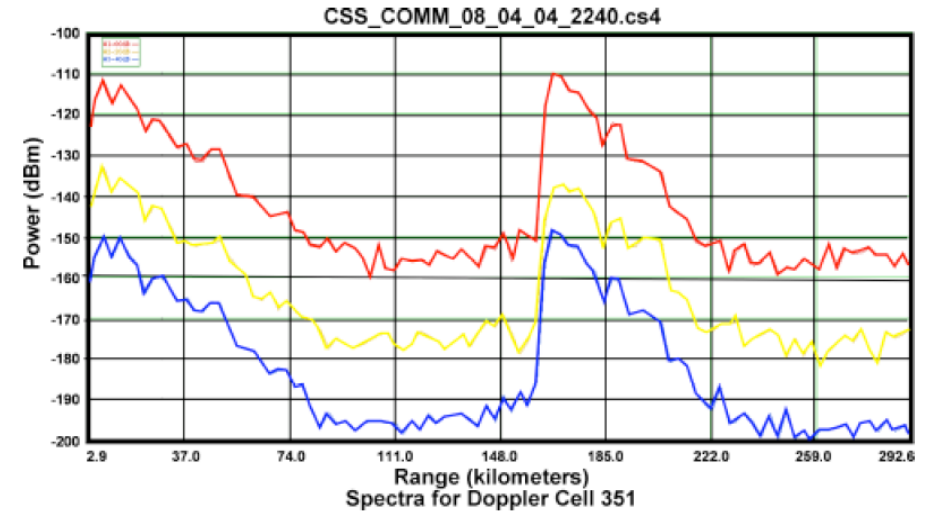
Figure 2. Received sea echo power vs. range at Doppler frequency 0.375 Hz measured by the an HF radar receiver located at Commonweal, California on April 04, 2008, 22:40, showing the offset between received backscatter echo (range < 90 km) and bistatic echo (160 km < range < 230 km) Red: Loop 1 Yellow: Loop 2 Blue: monopole. The channel powers have been artificially separated by 20